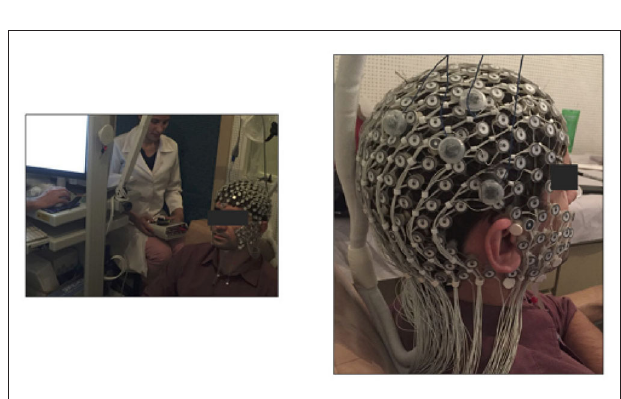
FIGURE 2 | Photograph of the experimental trial (left-hand side) and the EEG cap (right-hand side) with small electrode array covering the scalp, while the large electrodes identifiable as a triangle configuration (four electrodes total) represent the tDCS stimulating electrodes (this image was